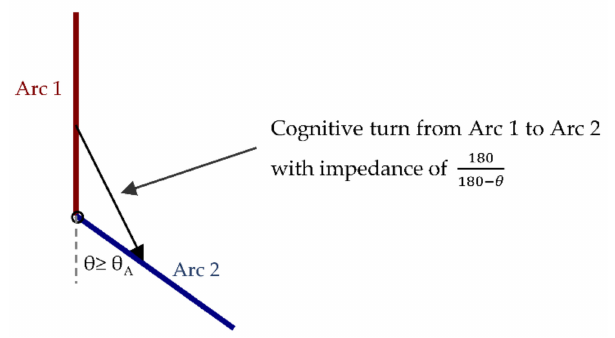
Figure 5. Angular cognitive turn definition.